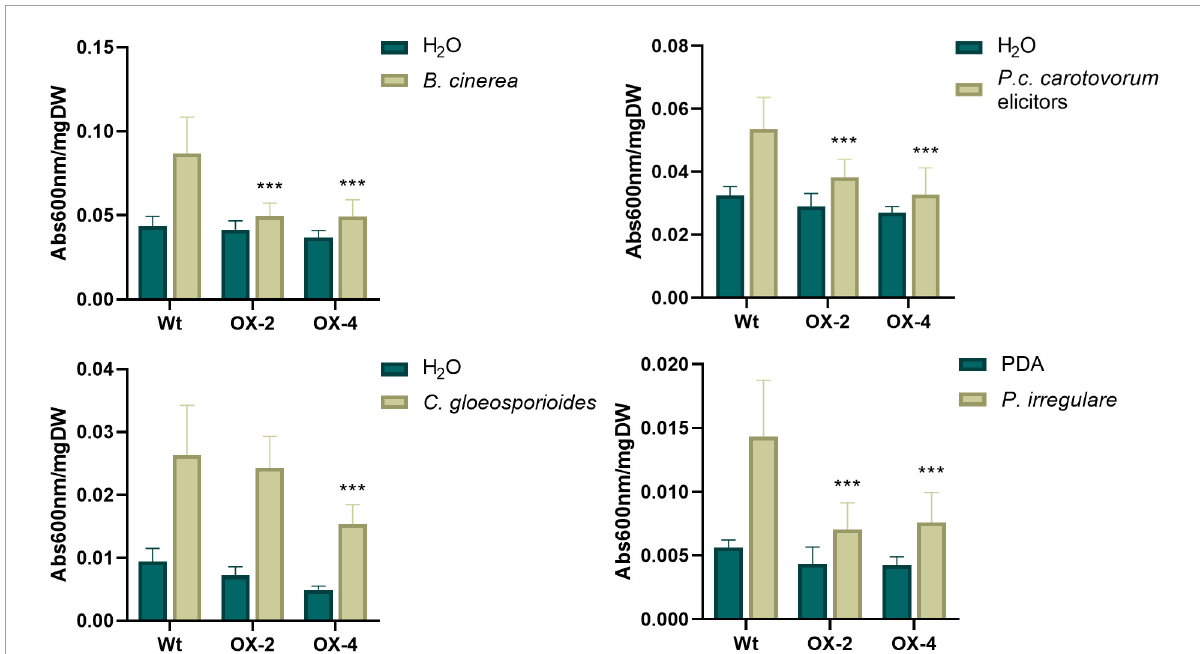
FIGURE3 Cell death measurement in wild-type and PpERF24 overexpressing plants. Measurement of cell death by Evans blue staining 24 h after inoculation of wild type, PpERF24-OX-2 (OX2), and PpERF24-OX-4 (OX4) moss colonies with B. cinerea, P. irregulare, and treatment with elicitors of P.c. carotovorum . Cell death measurement for plant tissues inoculated with C. gloeosporioides was performed at 72 hpi. Data were expressed as the absorbance (Abs) at 600 nm per milligram of dry weight (DW). Values are means with standard deviations of eight independent replicate moss samples. Experiments were repeated thrice with similar results. Asterisks indicate a statistically significant difference between the wild-type and overexpressing PpERF24 plants [two-way ANOVA test, with Tukey’s honest significant difference test as post hoc test using P ≤ 0.001 (***)].